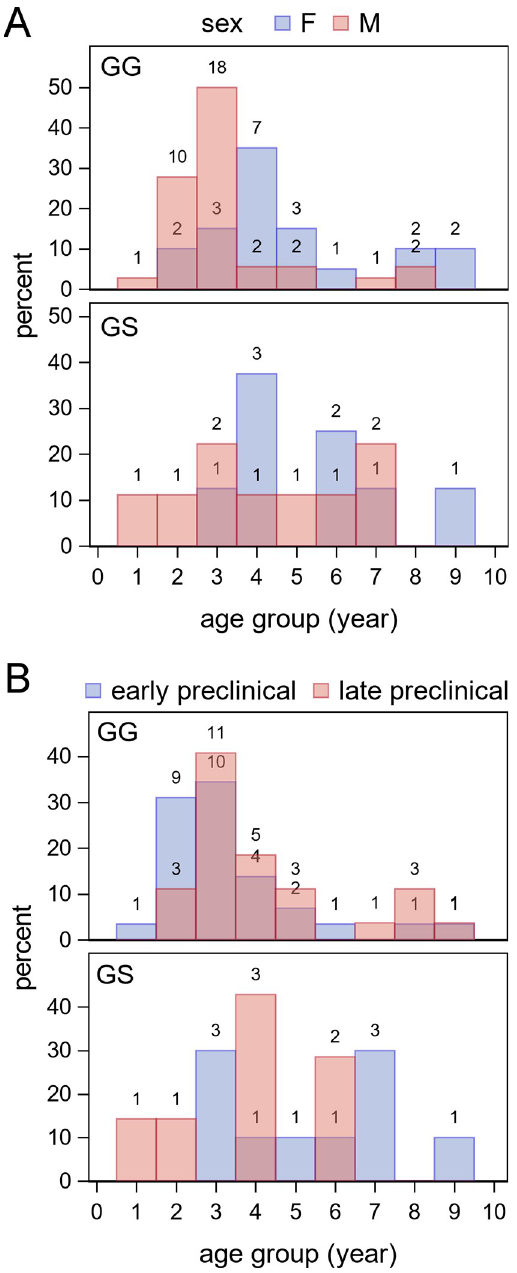
Fig 1. Distributions of ages by genotype at PRNP codon 96 grouped by sex (A) or stage of infection (B). The number of deer is indicated above each histogram bin. The agreement of results between sample types significantly depended on genotype (GG vs GS) stratified by stage of infection ( Q = 21.3860; P < 0.0001). For deer in late preclinical infec- c tion, there were no discordant pairs of results for either genotype, yielding a joint estimate of tonsil IHC diagnostic sensitivity in GG deer of 92.6% (exact 95% CLs: 75.7%, 99.1%) and in GS deer of 85.7% (42.1%, 99.6%); a significant difference between these joint sensitivities was not detected ( Q = 4.000, P = 0.1353). In contrast, during early preclinical infection there was C